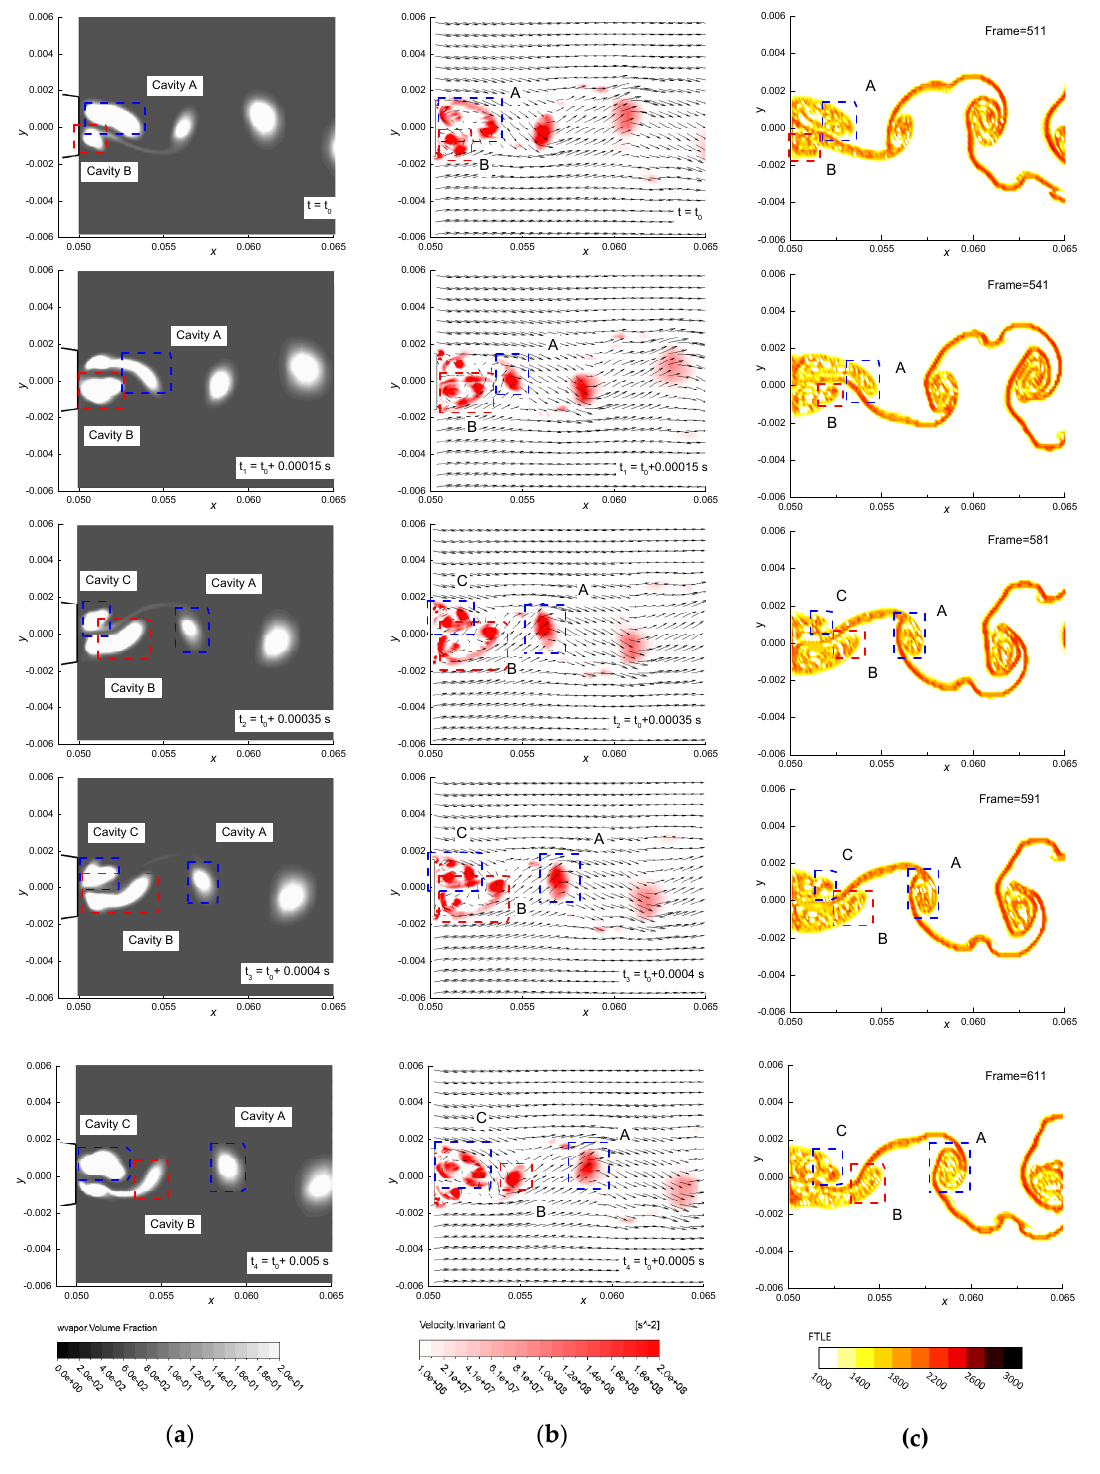
Figure 11. Plot for cavitation conditions ( σ / σ i = 0.4) at five correlative instants of time from top to bottom of: ( a ) vapor volume fraction distribution; ( b ) the instantaneous Eulerian Q criterion superposed to the instantaneous velocity; and ( c ) the backward finite-time Lyapunov exponent (FTLE).